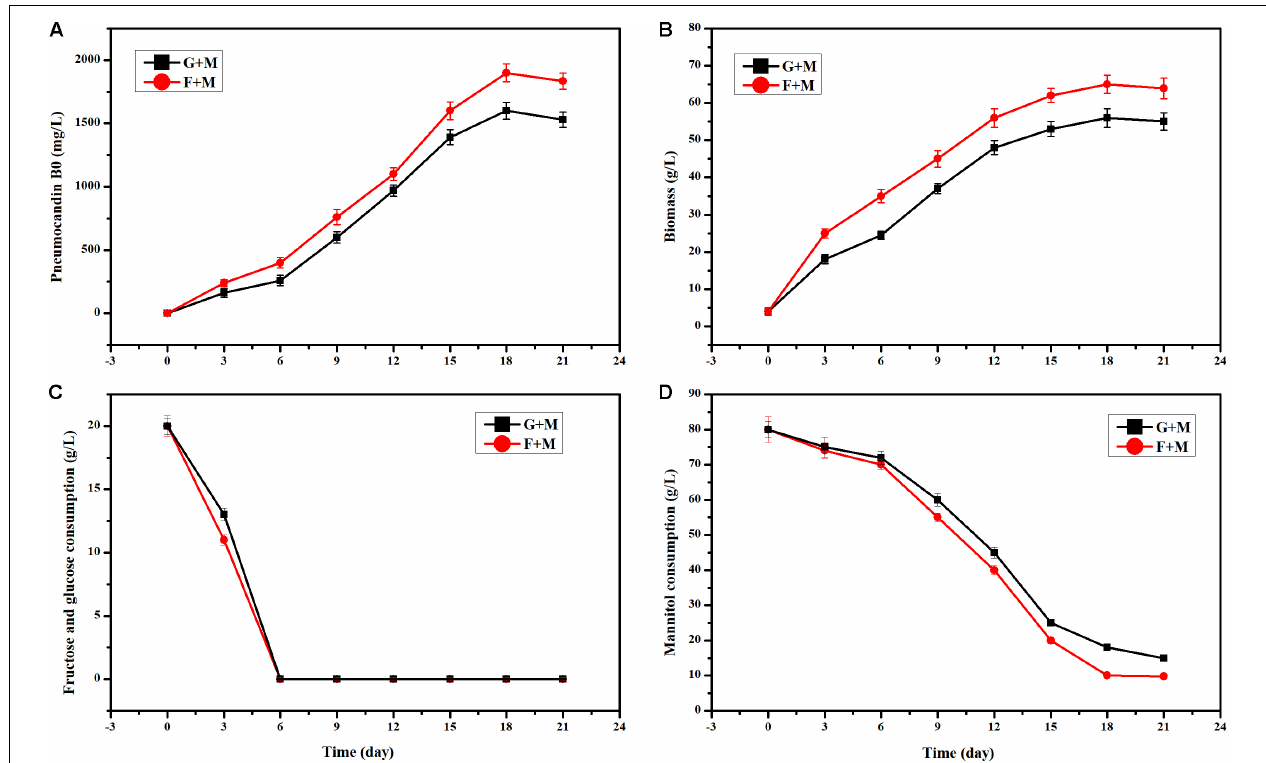
FIGURE 1 | Effects of different carbon source combinations on PB 0 production and biomass of G. lozoyensis. (A) Pneumocandin B 0 (mg/L), (B) Biomass (g/L). (C) Fructose and glucose consumption, (D) Mannitol consumption, G + M: 20 g/L glucose and 80 g/L mannitol, F + M: 20 g/L fructose, and 80 g/L mannitol. The data were presented as the averages of three parallel samples, and the error bars indicate the standard deviation (SD) from the means of